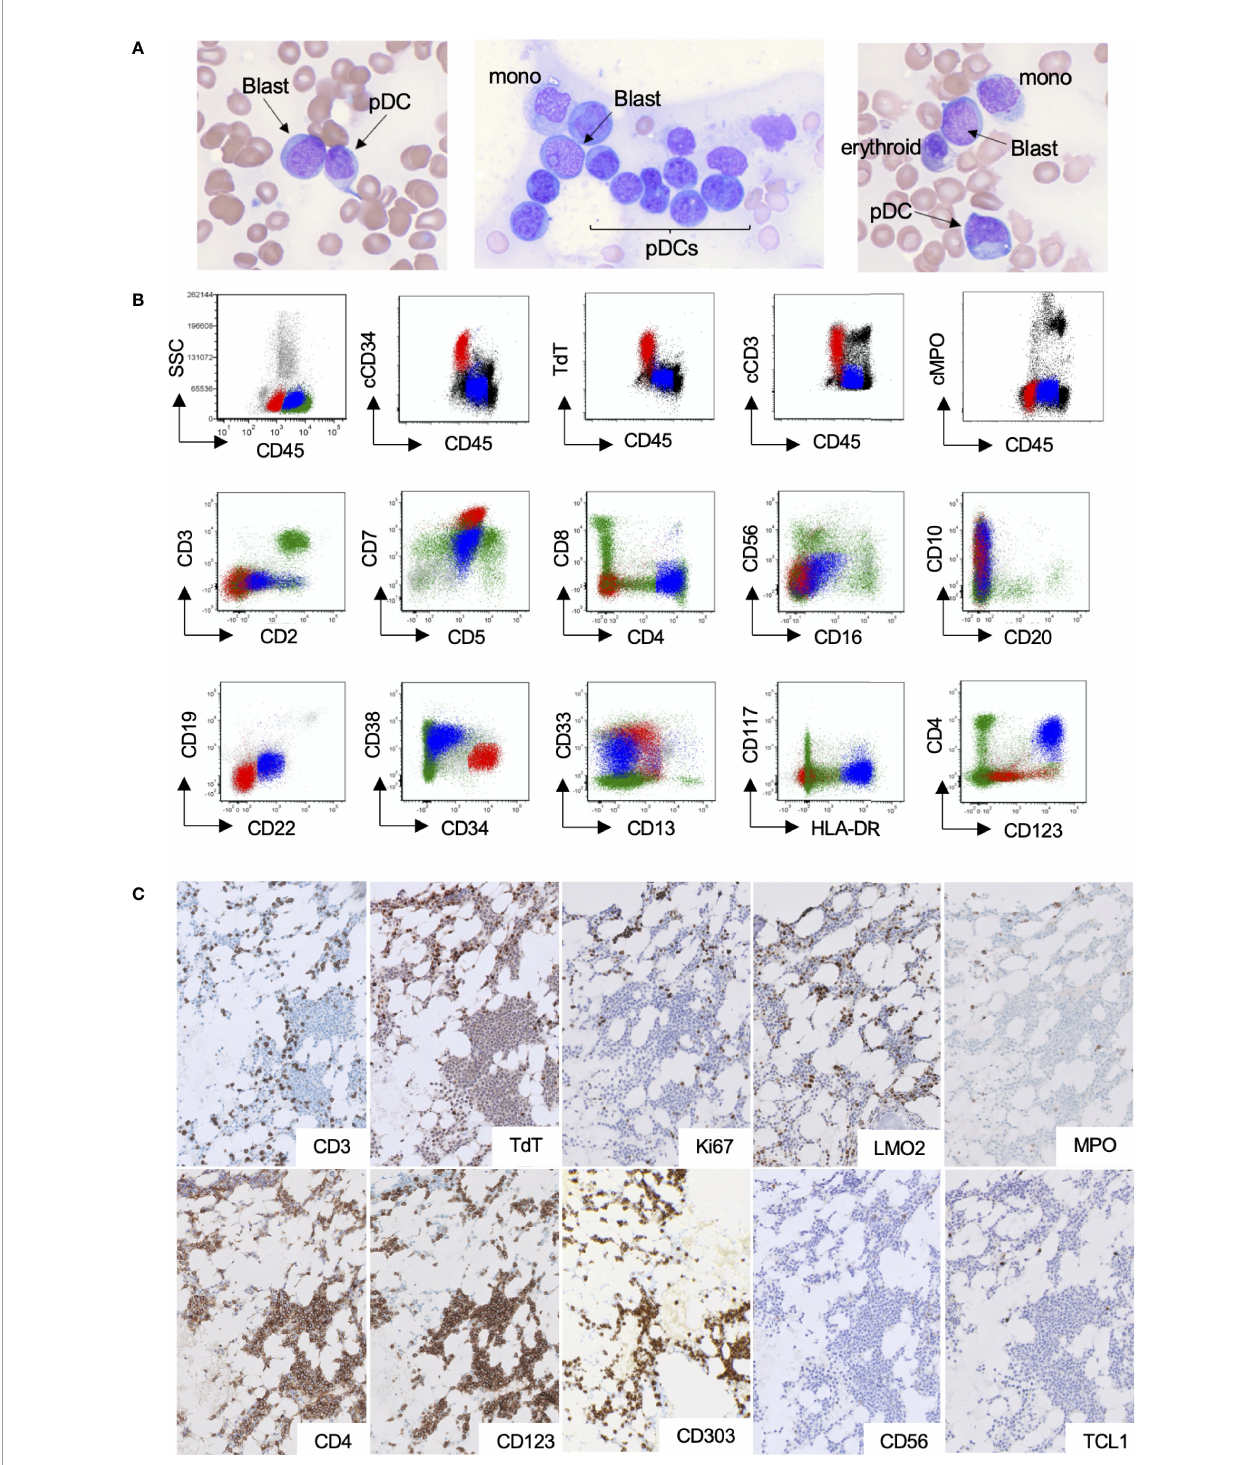
FIGURE 1 | pDC proliferation within the bone marrow of a patient with T-ALL. (A – C) Representative bone marrow Wright – Giemsa aspirates (×600 magni fi cation), demonstrating blasts, morphologically mature plasmacytoid dendritic cells, and other background hematopoietic cells. (B) Flow cytometry highlighting the abnormal T-lymphoblastic (red) and pDC populations (blue). (C) Immunohistochemical stains (×200 magni fi cation), highlighting small clusters of T lymphoblasts (upper panel) and large aggregates of pDCs (lower